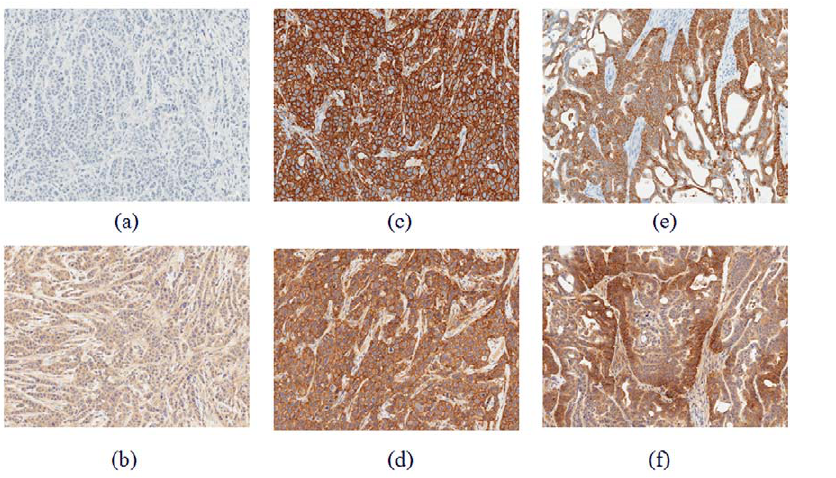
Figure 9. Histological (IHC) images of tumor tissues for tumor with no HER2 expression (A–B) MDA-MB-468, and highly expressed HER2 tumor (C–D) BT-474 and (E–F) NCI-N87. Tumor tissue was extracted from animals 24 hours post HER2-Affibody-DyLight750 injection, fixed in 10%NBF and analyzed by IHC for detection of HER2 status ( A,C and E ) and Affibody presence ( B,D and F ).